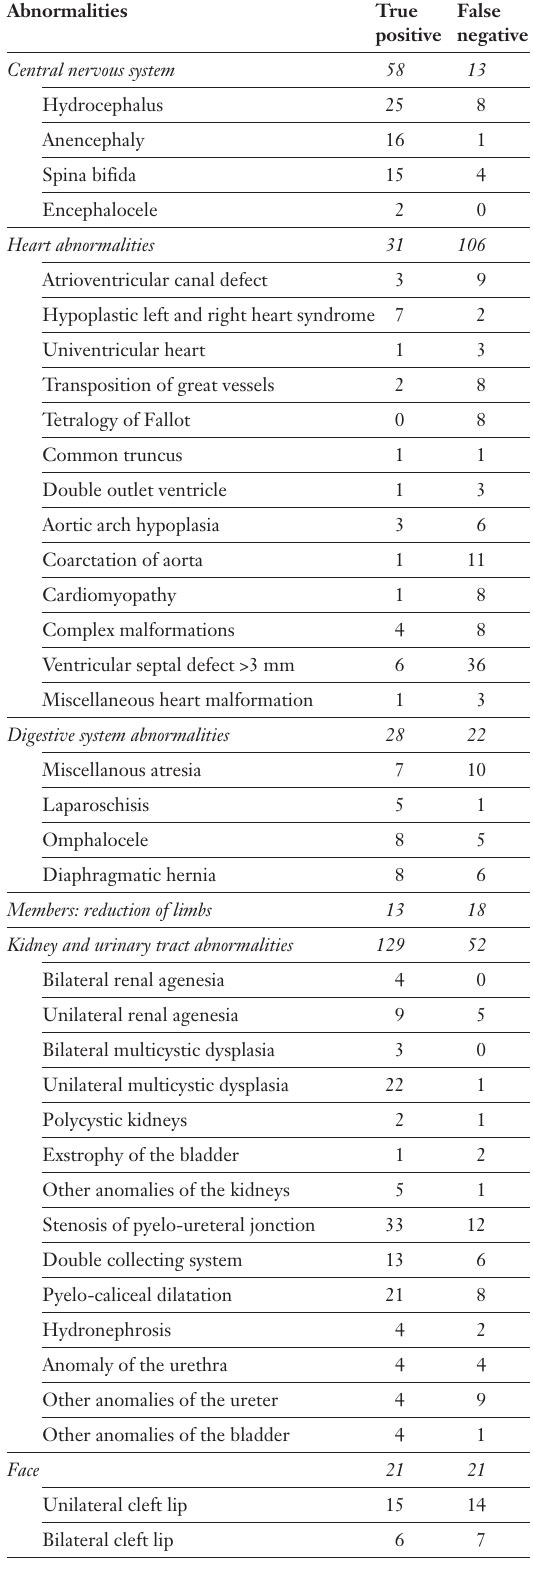
Table 1 Detection of foetal abnormalities by organs